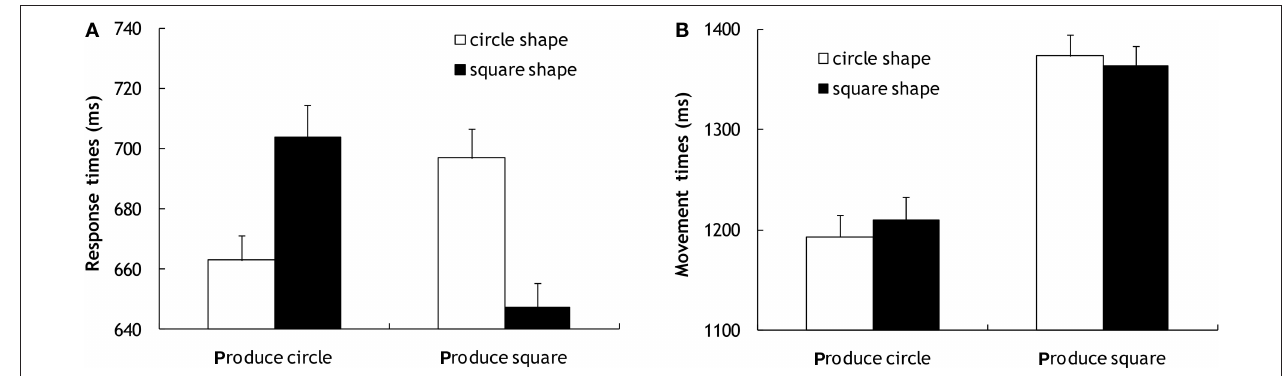
Figure 3 | response times (A) and movement times (B) in the location task in Experiment 2. Error bars show the standard error of the